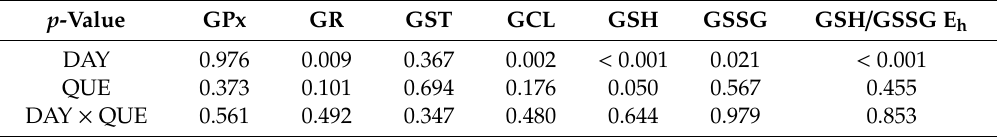
Table 6. Significance levels for treatment effects on the glutathione redox system in the distal jejunal mucosa of piglets at d5 and d14 post-weaning (DAY), fed a diet containing either 0, 100, 300, or 900 mg quercetin/kg diet (QUE) during the first 14d post-weaning ( n = 8). p -Value